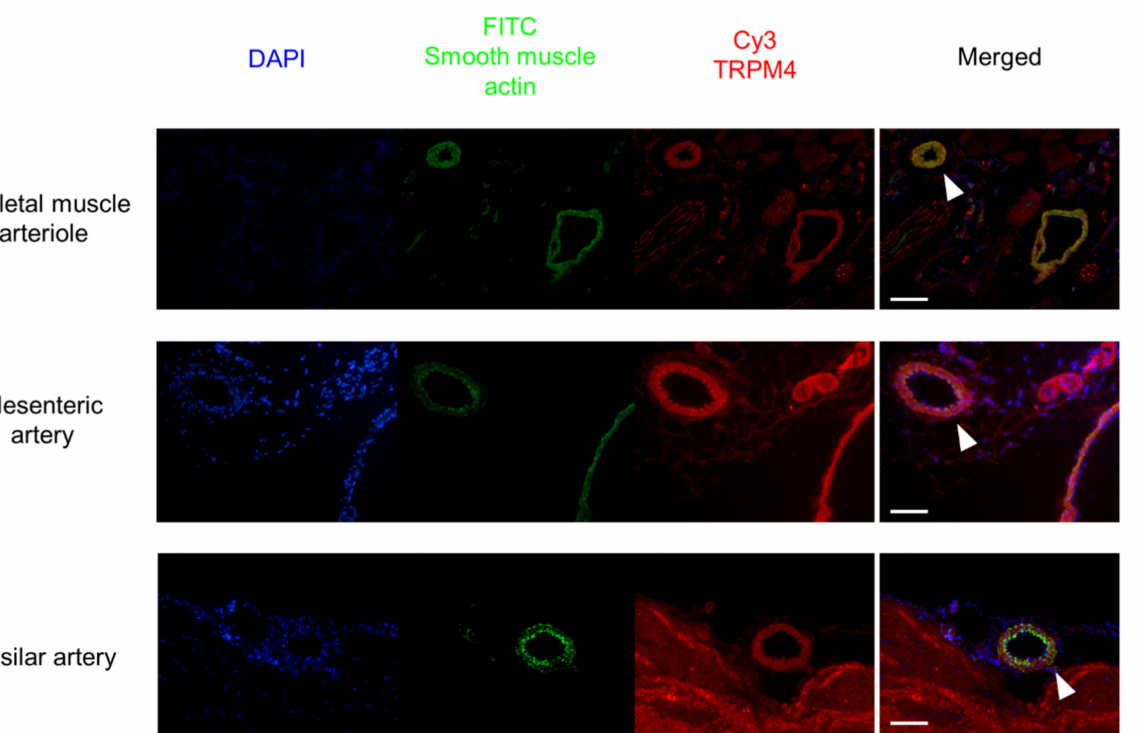
Figure 5. TRPM4 is expressed in the smooth muscle layers of blood vessels used in the functional studies. Tissue sections were prepared from skeletal muscle, mesentery, and brainstem. DAPI: nuclei (blue); FITC smooth-muscle actin: smooth muscle cells (green); Cy3-TRPM4 labeling (red). White arrowheads point to the blood vessels used in the functional studies on merged (overlayed) images. Scale bar = 100 µ m. Histological sections were prepared from three animals. It is not known whether the figures for separate arterial beds represent the same or different